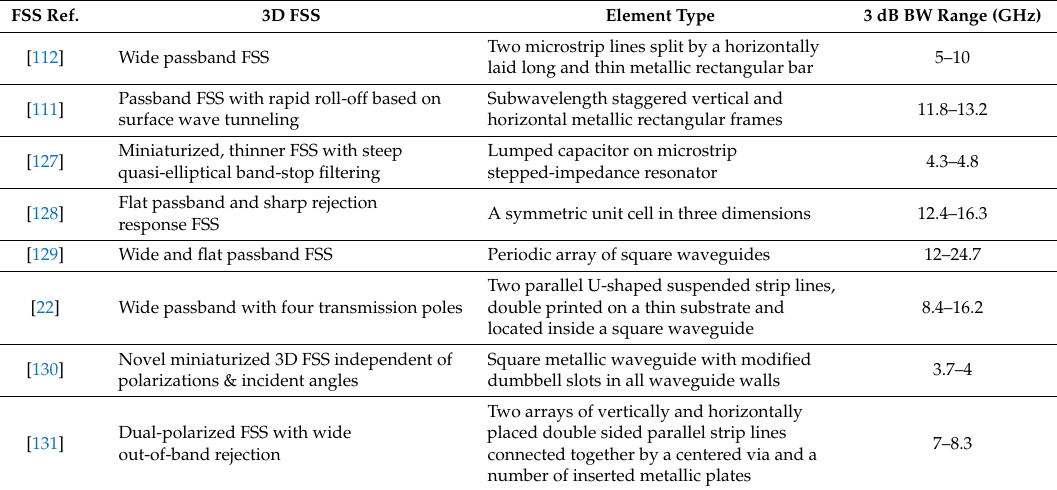
Table 6. An overview of 3D FSSs reported in different researches.